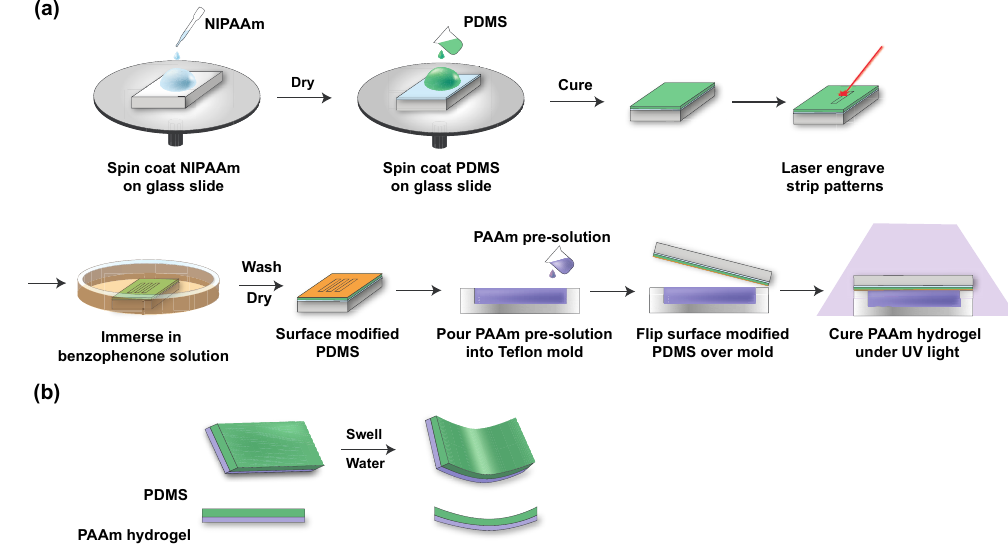
Figure 1. ( a ) Schematic illustration of the fabrication of the hydrogel/elastomer bilayer. ( b ) Mechanism of the shape transformation of the bilayer strip. Images not to scale.